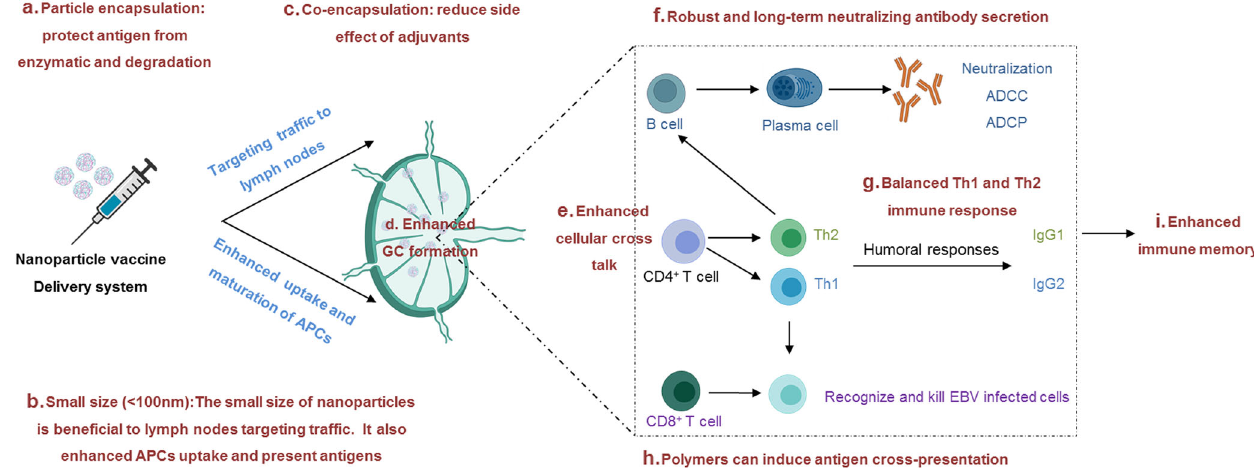
Fig. 2 Nanoparticle delivery system. a Nanoparticle vaccine delivery systems can protect antigens from enzymatic degradation. b Depending on the size of the nanoparticles, they can be passively delivered to lymph nodes and enhance antigen-presenting cells (APCs) to take up and present antigens. d Hence, germinal center (GC) formation is enhanced. c , e – h Nanoparticle vaccine delivery systems can induce cellular and humoral immune responses simultaneously with minimum side effects. i Besides, nanoparticle vaccine delivery systems can improve the levels of antigen-speci fi c memory T cells and B cells. The fi gure was made from